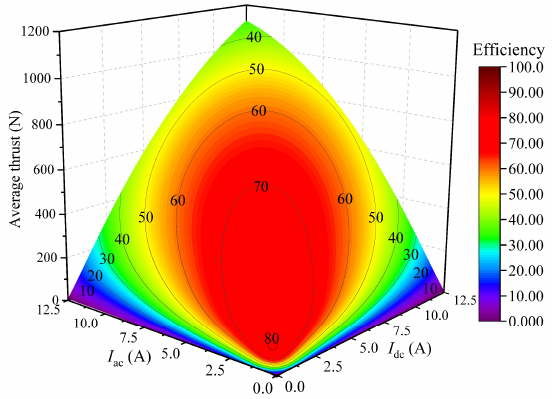
Figure 17. The average thrust and efficiency under different AC currents and DC currents of DCB-VRLM with non-uniform air gap.